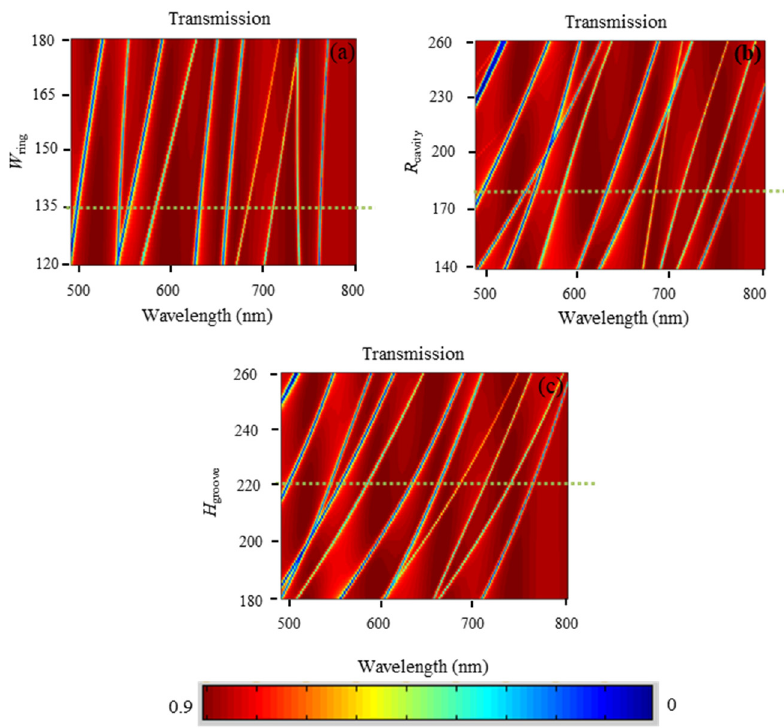
Figure 6. The wavelength shifts of the transmission dips when ( a ) the width W ring of the ring waveguide changed from 120 nm to 180 nm, ( b ) the radius R cavity of the metal-core circular cavity changed from 140 nm to 260 nm, and ( c ) the height H groove of the periodic air grooves changed from 180 nm to 260 nm.